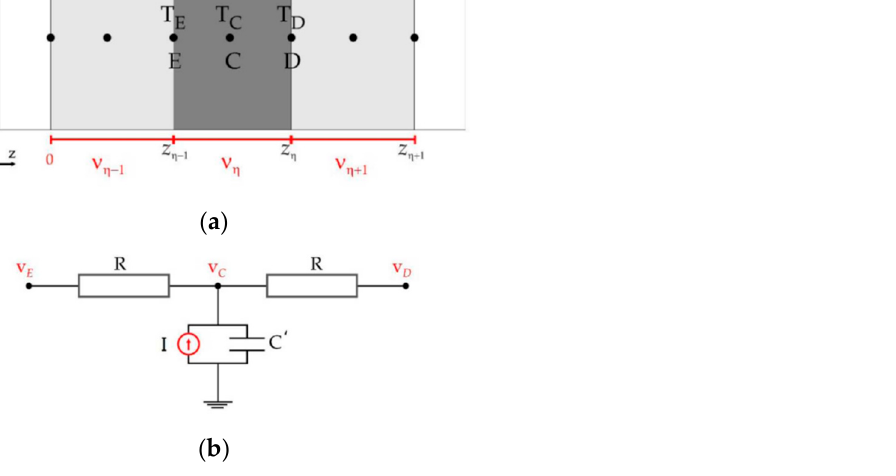
Figure 5. One-dimensional heat conduction. ( a ) Difference form of conduction equation; ( b ) equivalent circuit of conduction equation.